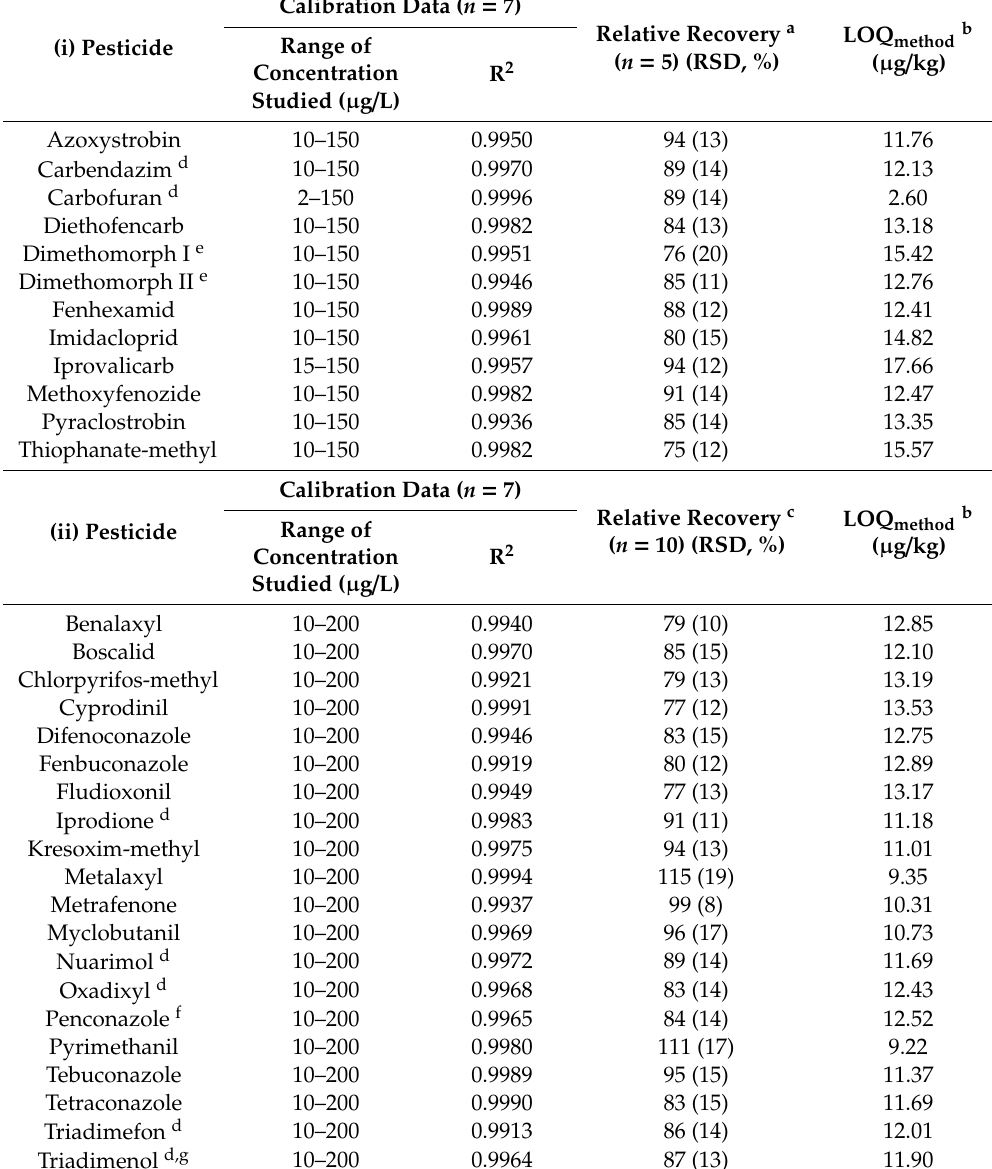
Table 1. Validation data of detected pesticides by (i) UHPLC-(Q-ToF)-MS / MS and (ii) GC-QqQ-MS / MS in red